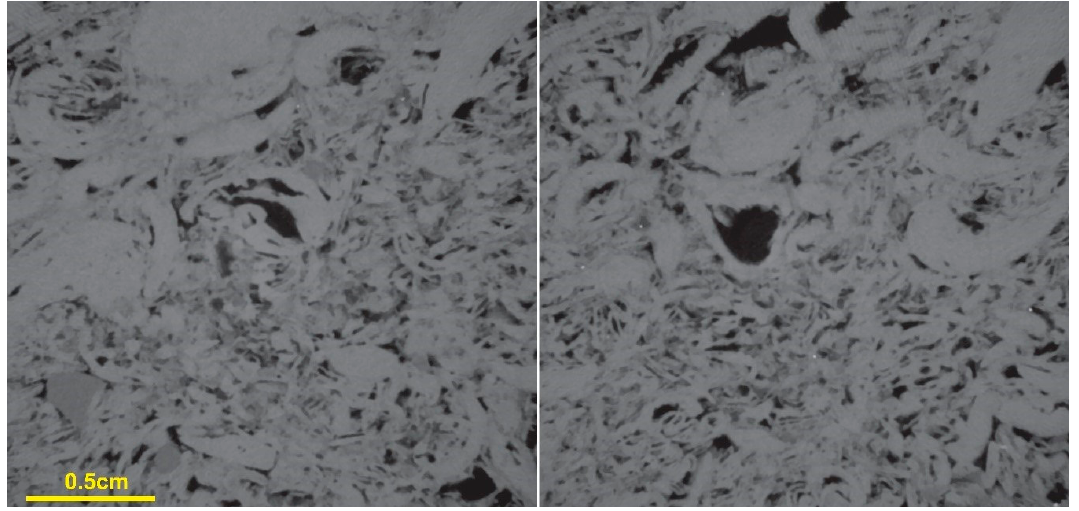
Figure 2. Slices from the micro-computed tomography (microCT) coquina sample with a pixel size of 9.98 μ m.